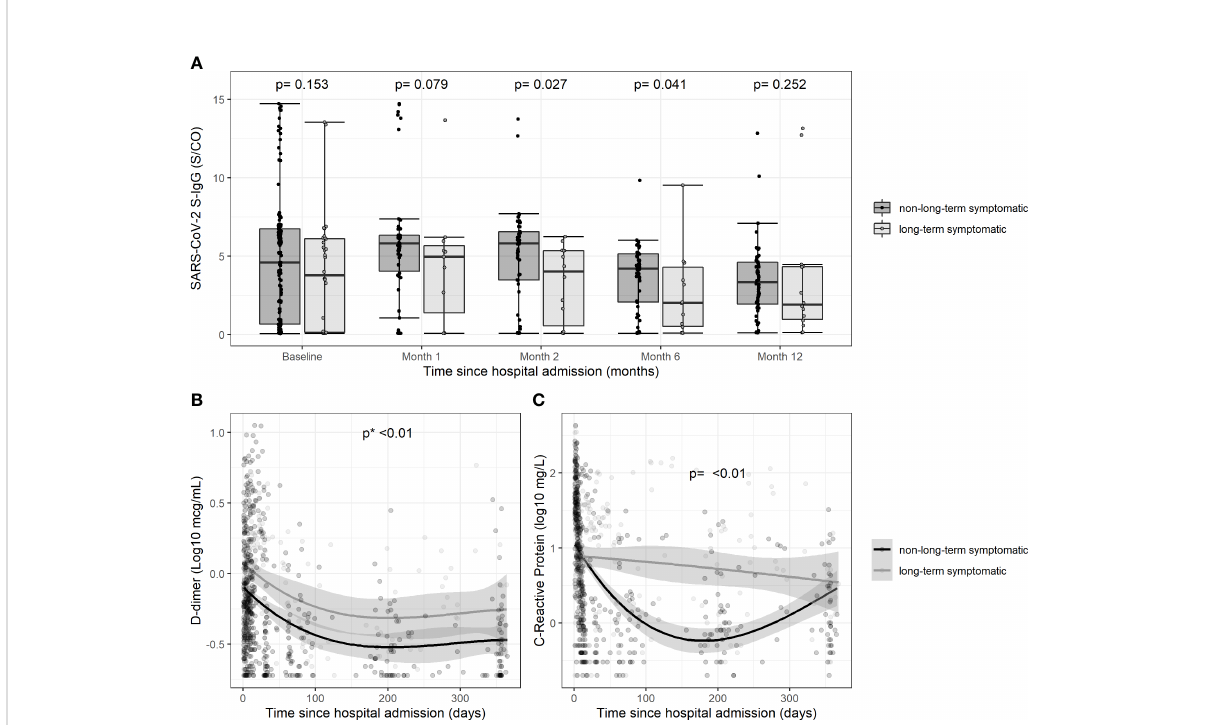
FIGURE 1 Temporal changes in the levels of antibodies and biomarkers during follow-up according to persistence of symptoms. (A) Serum titers of SARS- CoV-2 S-IgG on admission and at different time points after discharge according to the persistence of symptoms; (B) Serum levels of D-dimer during follow-up since hospital admission according to the persistence of symptoms; (C) Serum levels of C-reactive protein during follow-up since hospital admission according to the persistence of symptoms ”